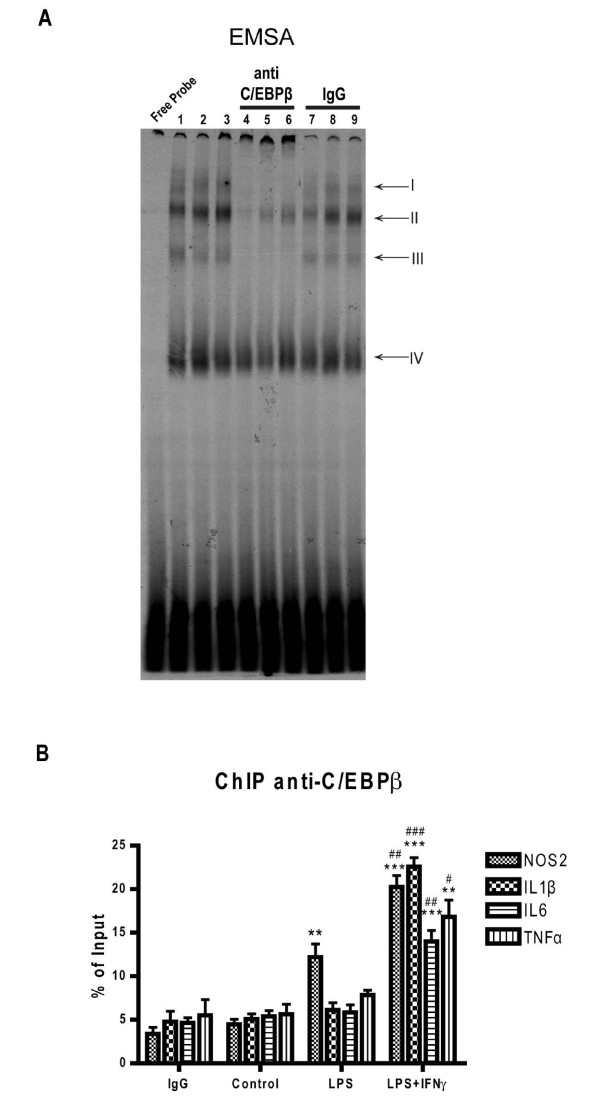
Binding of C/EBPβ to proinflammatory gene promoters in activated mixed glial cultures. A. C/EBPβ DNA binding activity was analyzed by gel shift and supershift assays. Nuclear proteins were extracted from secondary mixed glial cultures treated with vehicle (lanes 1, 4, 7), LPS (lanes 2, 5, 8) or LPS+IFNγ (lanes 3, 6, 9) for 2 h. The first lane represents the probe without nuclear extract incubation (free probe). Arrows indicate four shifted complexes. Complex IV is a C/EBPβ independent complex. Lanes 1 to 3 show C/EBPs shifting complexes in wild type condition. Supershift with anti-C/EBPβ antibody (lanes 4 to 6) shows the presence of C/EBPβ in I-III complexes in all treatments. Rabbit IgG (lanes 7 to 9) is used as negative control for the supershift assay. This image is representative of four independent experiments. B. Quantitative analysis of C/EBPβ binding to NOS2, IL-1β, IL-6 and TNFα promoters by qChIP in mixed glial cultures. The sequences and positions of every C/EBPβ binding site and the primers used for qPCR are found in table 2. IL-10 was used as positive control. The qChIP assay was carried out after 2 h of LPS, LPS+IFNγ or vehicle (control) treatment. The IgG bars represent the means for IgG/Control, IgG/LPS and IgG/LPS+IFNγ PCR values for each gene. Input refers to total DNA. % of input represents the percentage of qChIP/Input ratio. One-way ANOVA, followed by Bonferroni's multiple comparison test is applied. **p < 0.01; ***p < 0.001 compared to control. #p < 0.05; ##p < 0.01; ###p < 0.001 compared to LPS. (n = 3)